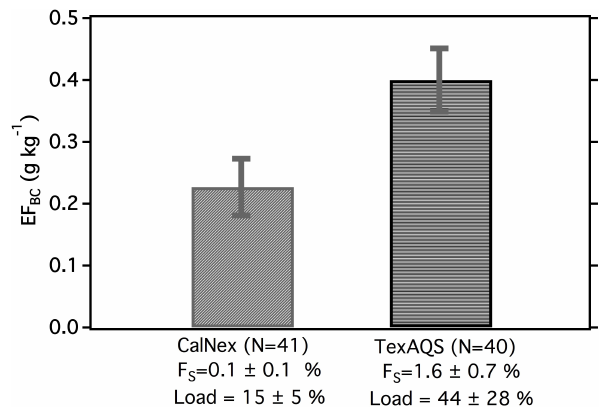
Fig. 7. EF BC (for SSD ships) in the California and the Gulf of Mex- ico/Houston coastal areas (Buffaloe et al.,